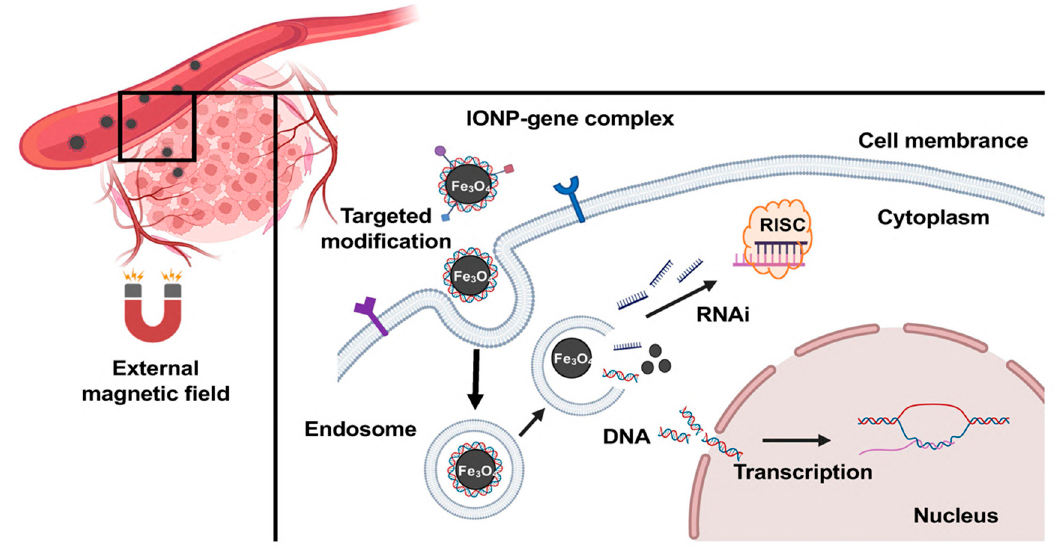
Figure 1. Schematic illustration of using IONPs to deliver gene drugs to tumor sites. Table 1. Examples of using IONPs for efficient gene delivery targeting to tumors.